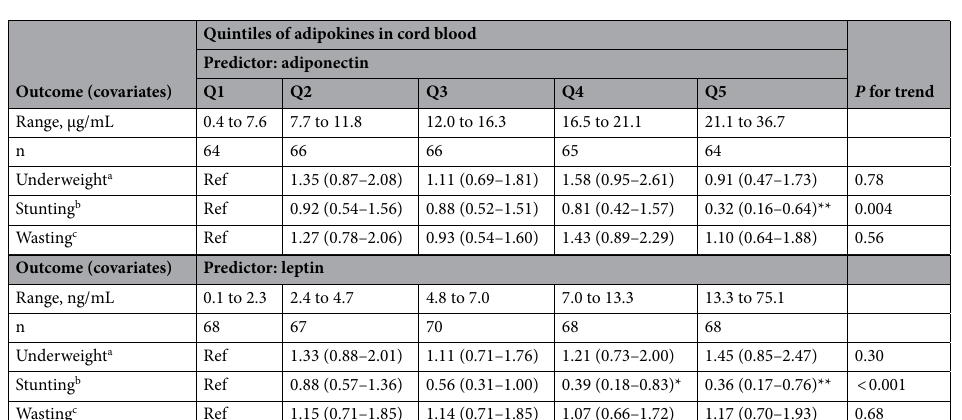
Figure 1. Weight-for-age z-score (WAZ), height-for-age z-score (HAZ), and weight-for-height z-score (WHZ) according to quintiles of adiponectin ( A–C ) and leptin ( D–F ) in cord blood. Error bar indicates standard deviation. Filled circle: quintile 1—the lowest level, filled square: quintile 2, filled triangle: quintile 3, filled inverted triangle: quintile 4, filled diamond: quintile 5—the highest level. * P value < 0.05, ** P value < 0.01, *** P value < 0.001.